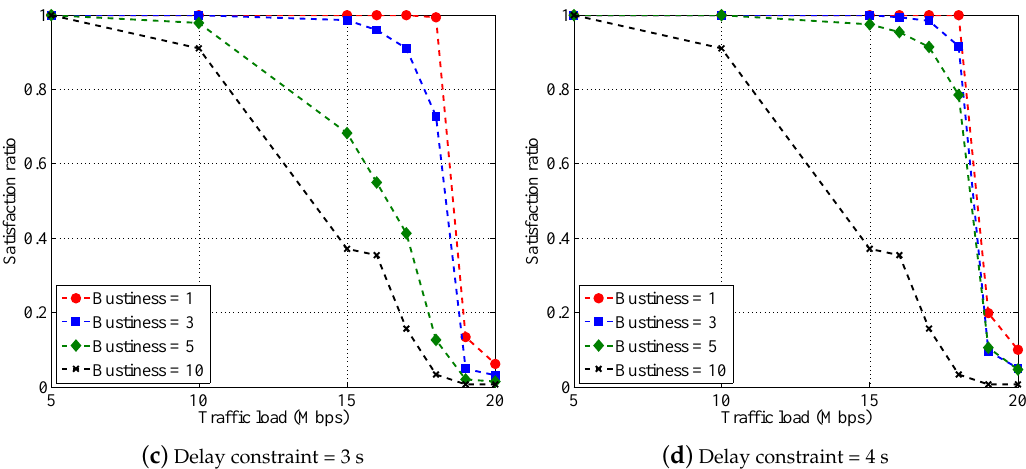
Figure 10. The satisfaction ratio when the spectral efficiency is 3 bps/Hz when the traffic load varies from 5–20 Mbps and burstiness varies from 1–10 (RBDC).